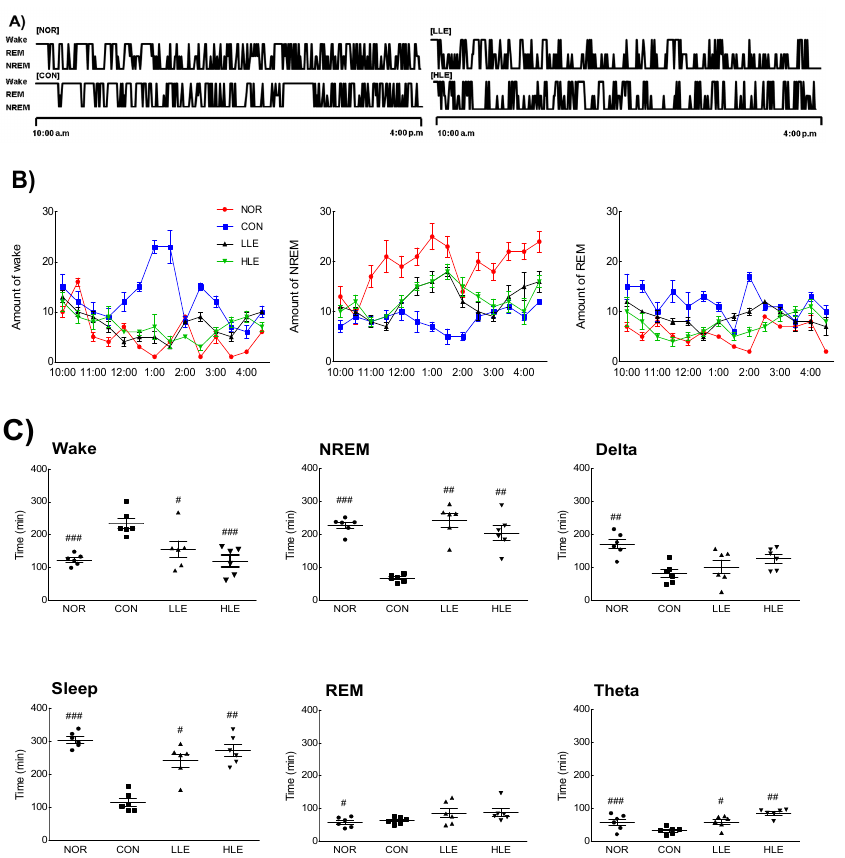
Figure 3. Effects of the ethanol extracts of lotus leaf on electroencephalography of caffeine-induced insomnia model ( n = 6/group). ( A ) Hypnograms that represent concatenated 1 min epochs of EEG activity, scored as wake, rapid eye movement sleep (REM), non-rapid eye movement sleep (NREM) sleep on day 9. ( B ) Changes on wake, REM, NREM after oral injec- tion for 7 h ( C ) Average time of awakening, sleep, non-REM, REM, delta waves, and theta waves for 9 days. NOR: normal group; CON: caffeine-treated group (80 mg/kg); LLE: low dose of ethanol-extracted lotus leaf-treated group (150 mg/kg) with caffeine; HLE: high dose of ethanol-extracted lotus leaf-treated group (300 mg/kg) with caffeine; REM: rapid eye movement sleep; NREM: non-REM. Values are means ± standard error of the mean for each group. # p < 0.05, ## p < 0.01, and ### p < 0.001 vs. CON. 2.5. Effect of Q3G on Sleep Enhancement and Binding Activity to the GABA A Receptor The concentration of the antioxidant compounds polyphenols and flavonoids in the ethanolic lotus leaf extract was high; therefore, the concentration of Q3G, a type of phe- nolic compound, was analyzed by HPLC (Figure S1). Q3G concentration in the ethanolic lotus extract was 77.27 μ g/mg, which is approximately 8% of the lotus leaf extract (Figure S1). When the dose of the ethanolic lotus leaf extract was 300 mg/kg (Figure 2), which showed a significant difference compared to NOR group, the estimated dose of Q3G was